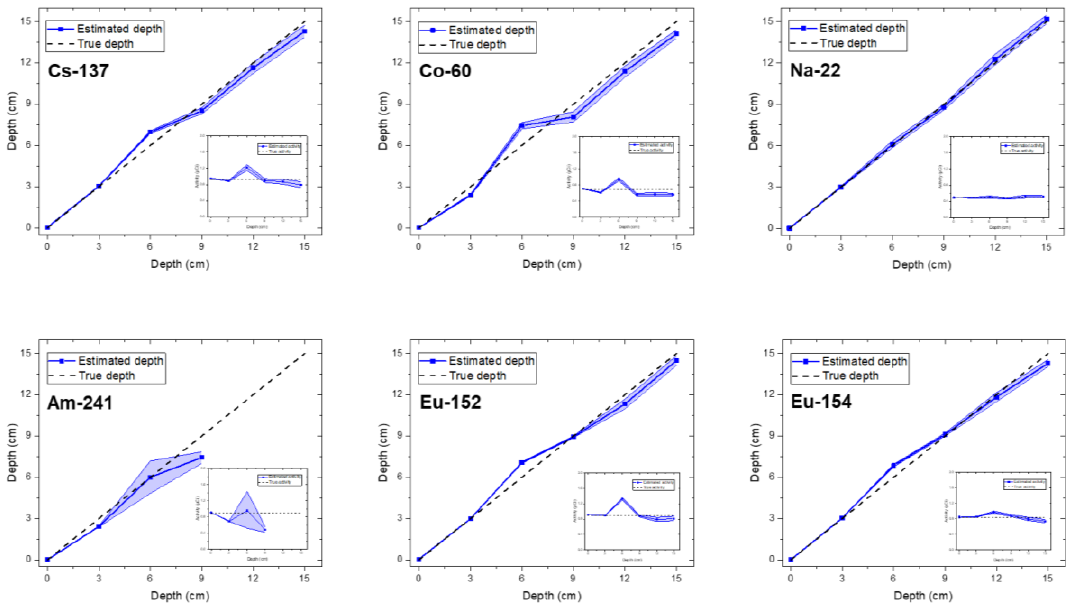
Figure 4. Estimated depth and activity with a 95% credible interval for the single radioisotope of Cs-137, Co-60, Na-22, Am-241, Eu-152, and Eu-154 buried in sand over the range of 0–15 cm at 3 cm intervals. The inset shows the estimated activity of the corresponding radioisotope in each figure.